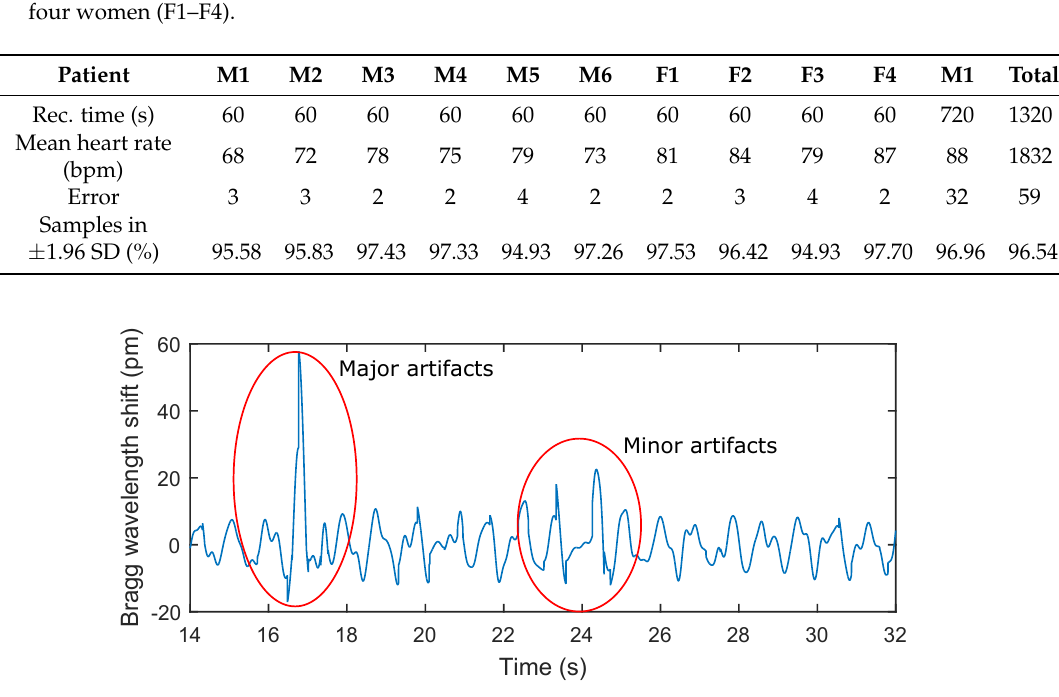
Figure 13. A recording from a female subject in this study. Subject F3 was asked to simulate strong coughing and to change her position. For example, the influence of strong coughing on the heart rate is shown in red on the left (major artifacts) and the influence of a position change on the heart rate is shown in red on the right (minor